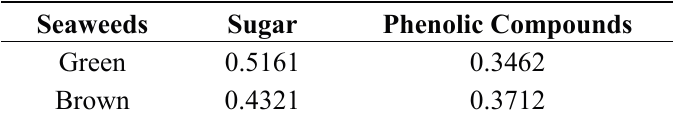
Table 1. Correlation coefficients between the amount of phenolic compounds or sugar of extracts and their cytotoxicity of each class of